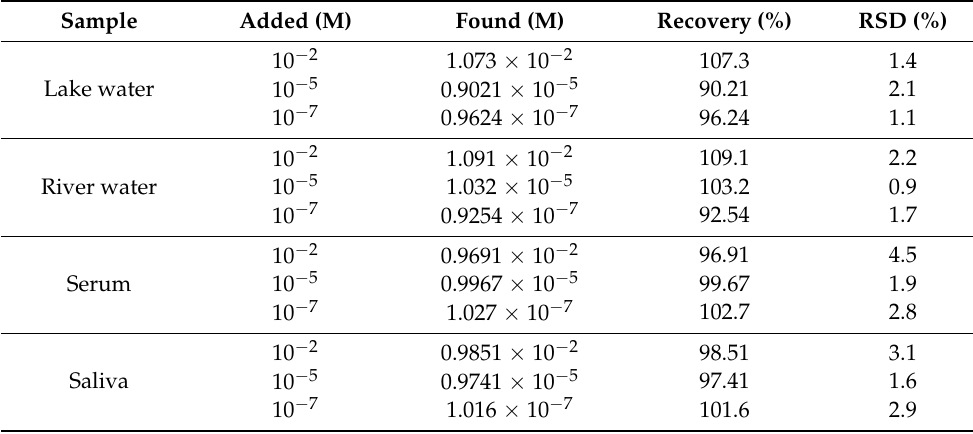
Table 2. Recoveries for detecting N 2 H 4 in real samples ( n =